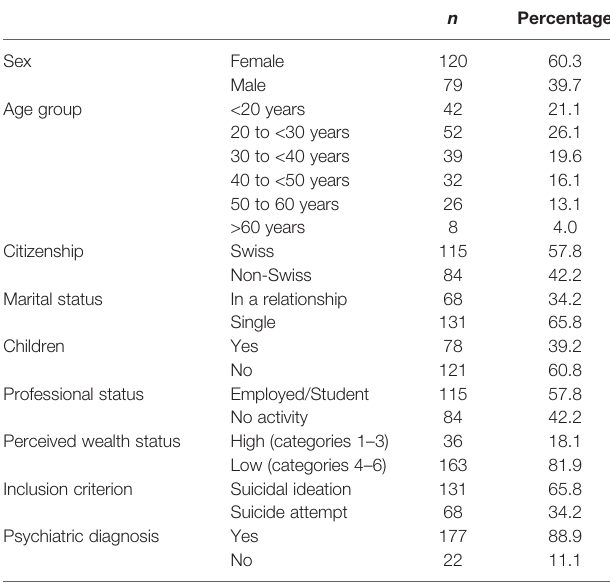
TABLE 1 | Psychosocial characteristics ( N =